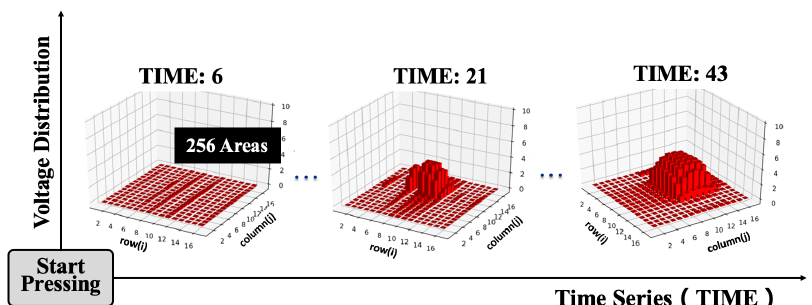
Figure 4. Dynamic raw voltage data distribution.